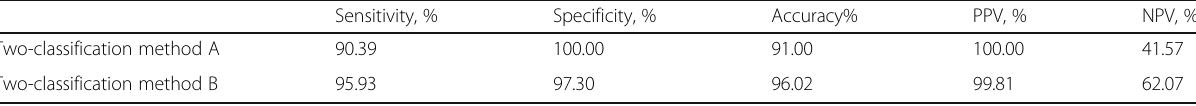
Table 4 Value of CNB for Preoperatively Evaluating Malignancy of Thyroid Nodules Sensitivity, % Specificity, %